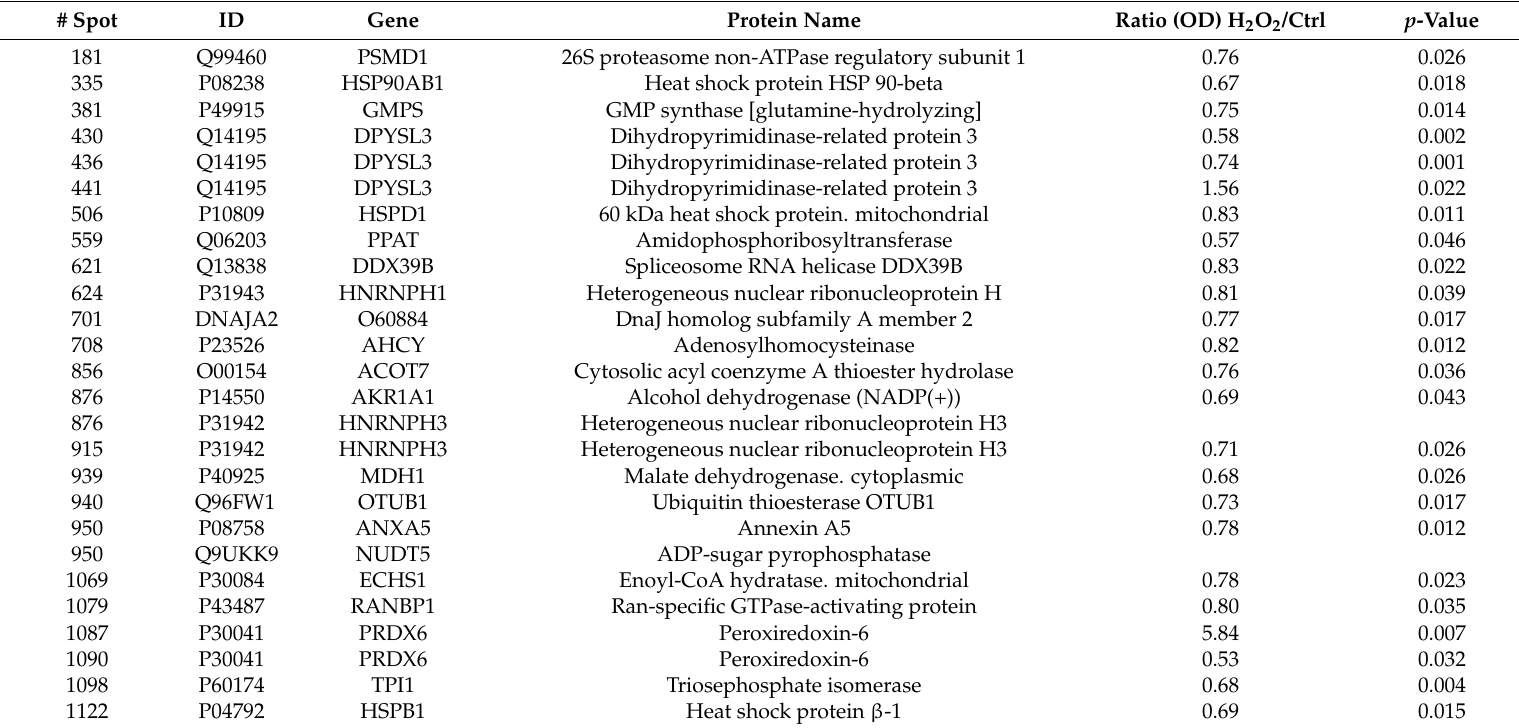
Table 2. List of differentially expressed proteins after comparison between H 2 O 2 vs. Control (ctrl). ID: SwissProt accession Number; OD: Normalized optical